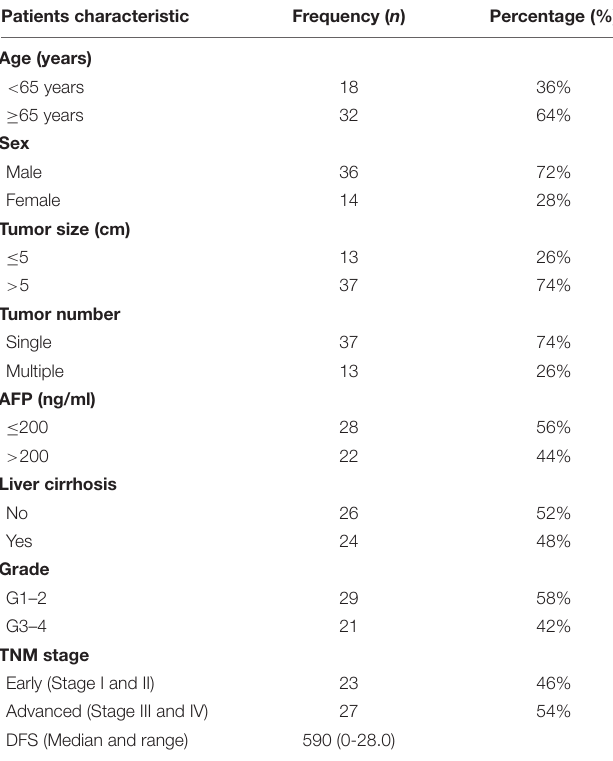
TABLE 1 | Major demographic and clinicopathological characteristics of hepatocellular carcinoma cases ( n = 50). Patients